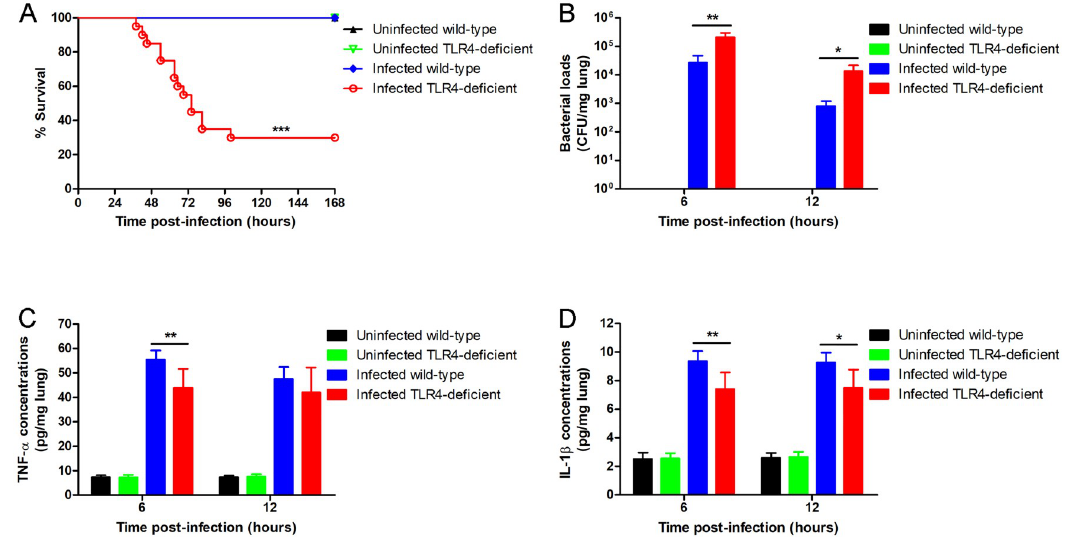
Fig 3. TLR4 deficiency reduces host resistance to S . pneumoniae . Wild-type and TLR4-deficient mice were intra-nasally inoculated with 2.3 × 10 8 CFU of S . pneumoniae . (A) The survival was observed for 7 days (n = 20 per group). (B) Bacterial load, and (C) TNF- α and (D) IL-1 β concentration per mg lung tissue were determined 6 hours and 12 hours after infection (n = 6 per group). CFU, colony-forming units. Data are presented as means ± SD. � P < 0.05, �� P < 0.01, ��� P < 0.001, analyzed with the log-rank test or unpaired Student’s t